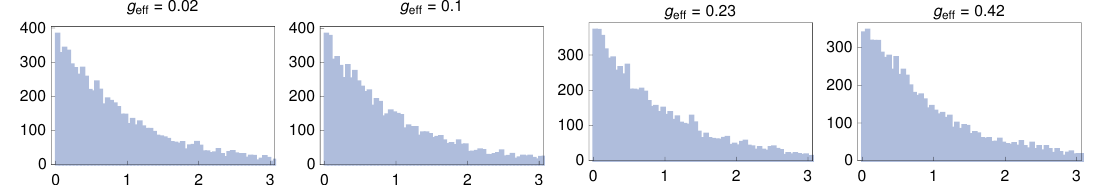
Figure 7: Level spacing statistics of H by first order perturbation theory for the case L = 22, ∆ = 0.2, for different values of the